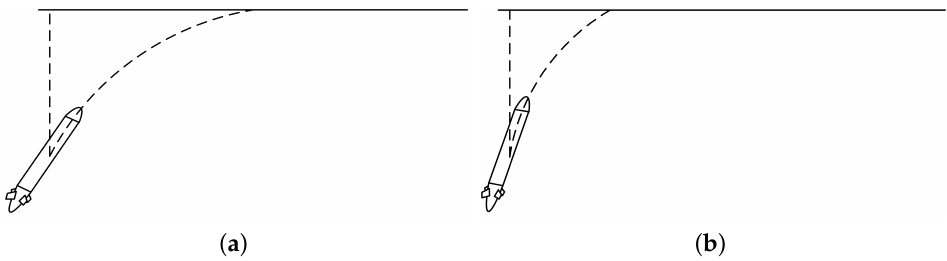
Figure 8. Convergence performance under of different speed. ( a ) high forward speed; ( b ) low forward